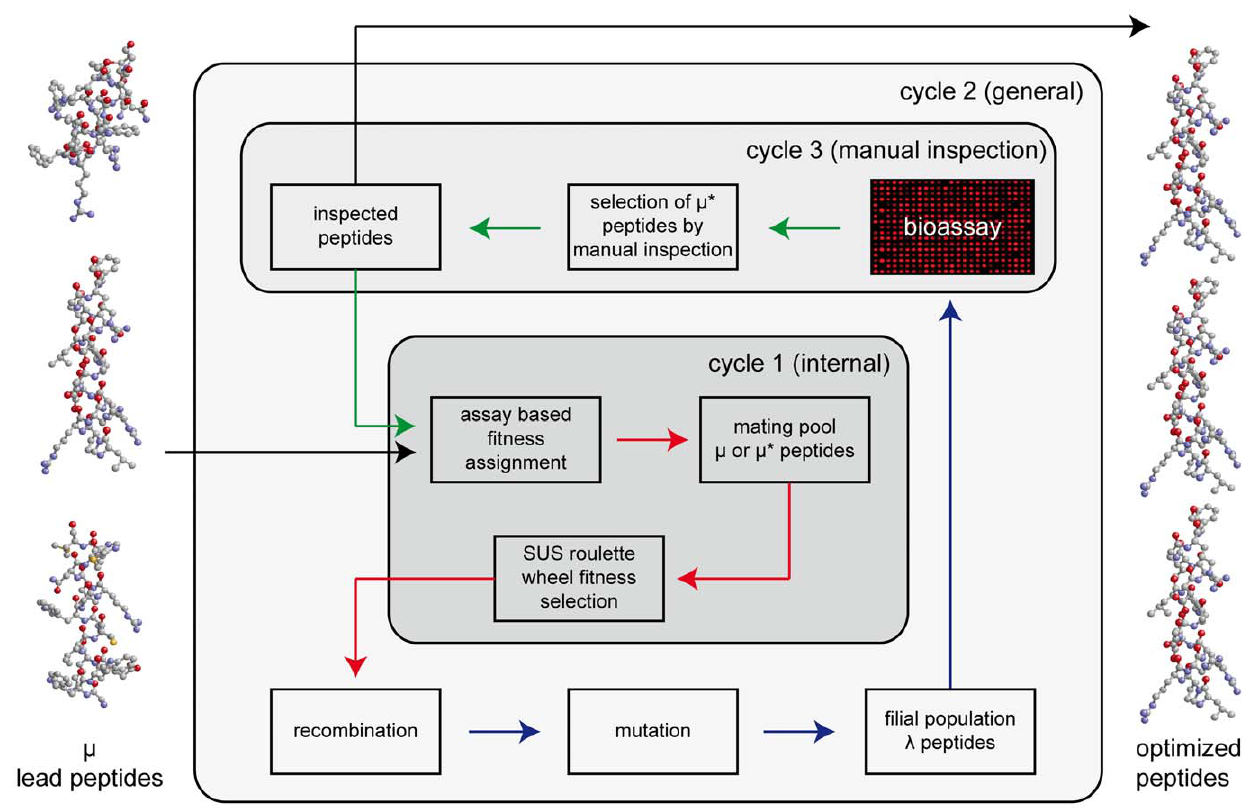
Figure 2. Diagram of the evolutionary optimization process. The process is divided into three cycles, an internal, genetic algorithm (GA)-like cycle 1, a general, evolutionary strategy (ES)-like cycle 2, and a bioassay-based cycle 3 which includes the selection of peptides by manual inspection. Internal cycle 1: fitness assignment to lead or parent peptides, generation of a mating pool of m or m * peptides, nonlinear fitness scaling of all the assigned values and afterwards -times stochastic universal sampling (SUS) by a roulette wheel function of the peptides from the mating pool for recombination. General cycle 2: -times recombination and subsequent mutation with specific gaussian variation of the recombination and mutation setup thereby creating a filial population of peptides. Cycle 3: biochemical testing and manual inspection of the resulting population in the bioassay and manual selection of m * peptides out of peptides in the filial population to act as new parent peptides in the next generation.